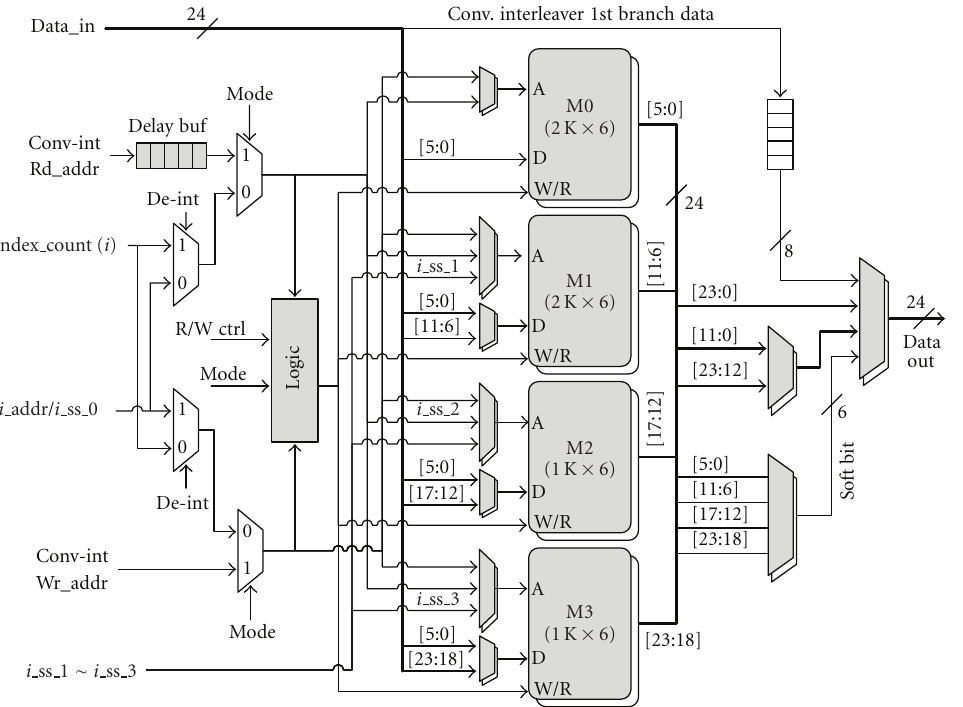
Figure 6: Memory address selection and data